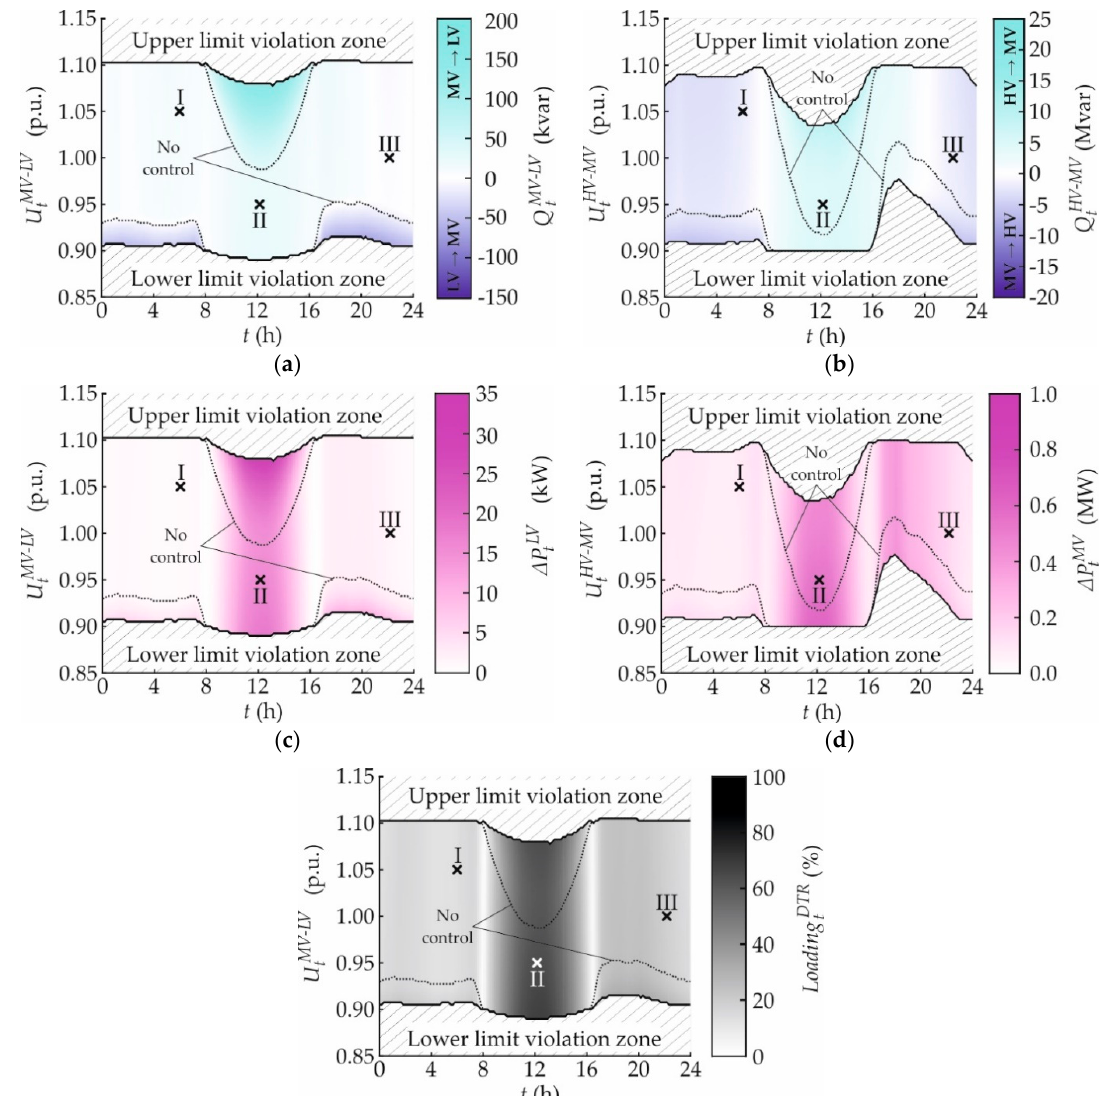
Figure 18. Daily behavior of the test link chain for various boundary voltages and the X ( U ) local control: ( a ) reactive power exchange over the MV − LV boundary (rural LV_Link-Grid); ( b ) reactive power exchange over the HV − MV boundary; ( c ) active power loss within the rural LV_Link-Grid; ( d ) active power loss within the MV_Link-Grid; ( e ) DTR loading (rural LV_Link-Grid).